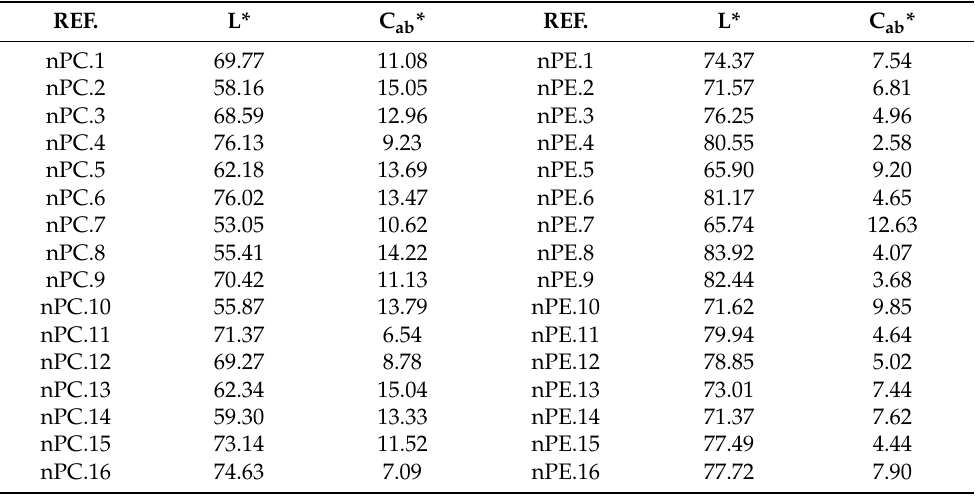
Table 4. L* and C ab * values for the PE and PC hybrid pigments under different